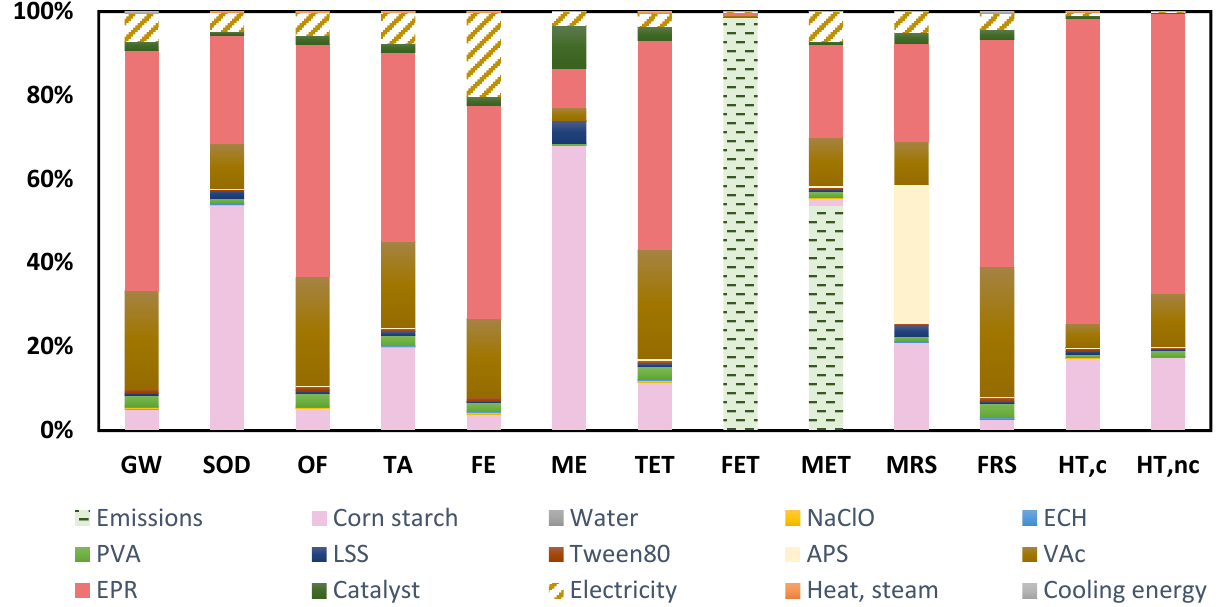
Figure 5. Environmental profile of the starch bioadhesive oxidized with NaClO and ECH (Alternative 4). As can be seen, two main items stand out in most of the impact categories: epoxy resin and corn starch, except for FET, MET and MRS. Regarding the FET and MET categories, the emissions released within the bioadhesive production process are the ones with